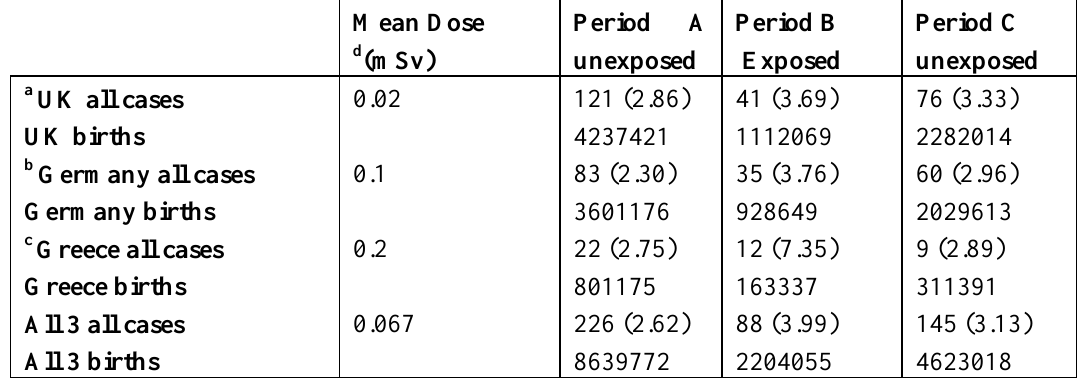
Table 3. Infant leukemia in UK Greece and Germany in the Chernobyl in utero exposure periods, (with rates per 100,000 and mean population-weighted fetal doses).